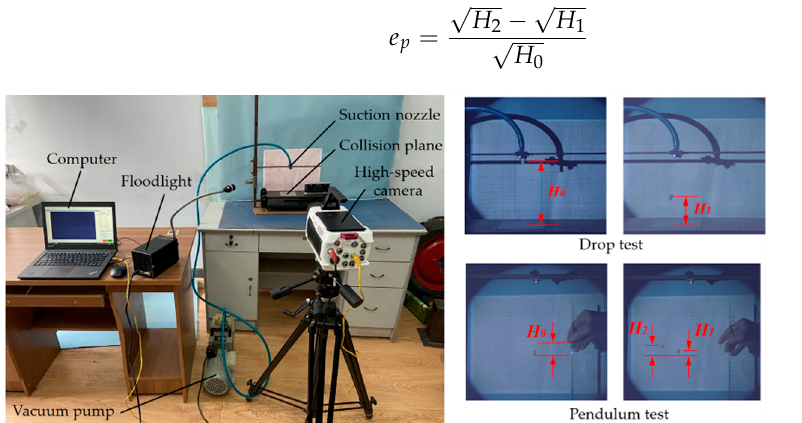
Figure 4. Platform to test the restitution coefficient.